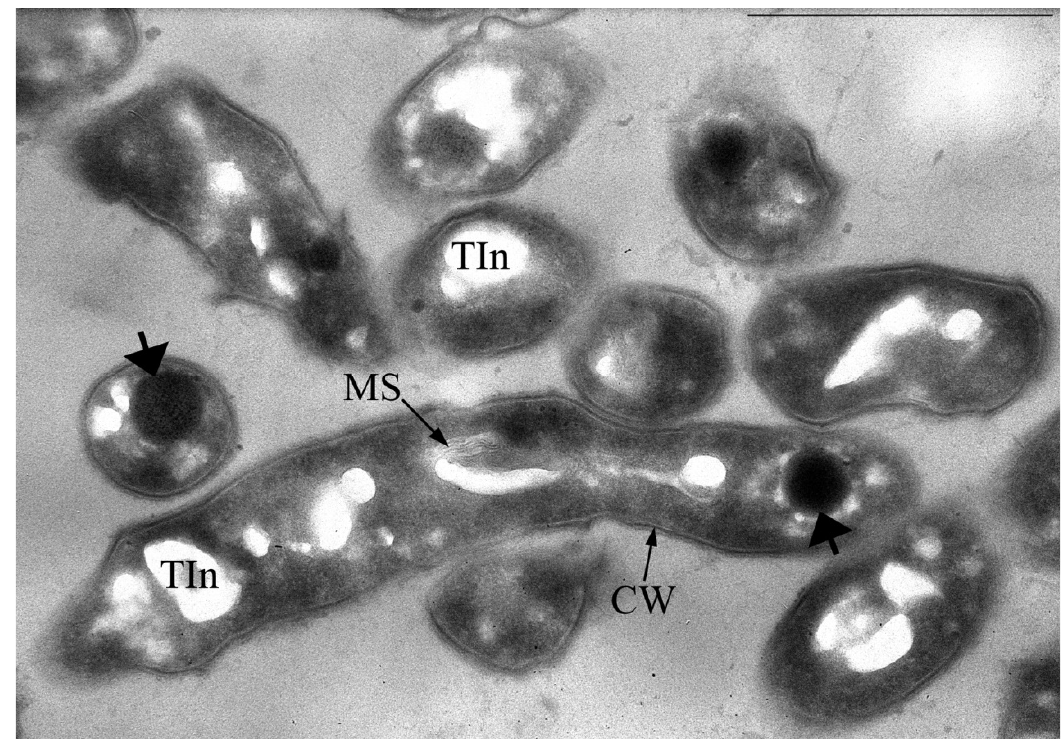
Figure 10. Ultrathin section of G. polyisoprenivorans 135 cells 24 h after the start of germination. The appearance of membrane-like structures (MS), reduction in acidocalcisome-like ultrastructures, and the appearance of large polar electron-dense spherical inclusions (indicated by thick arrows) are detected. Transmission electron microscopy. Ultrathin section. Designations: CW—cell wall; Tin—electron-transparent inclusion; MS—membrane-like structures. Bar—1 µ m. Table 2. Ability of G . polyisoprenivorans 135 culture to induce biodegradation enzymes after resting. Cell Storage Time in LB